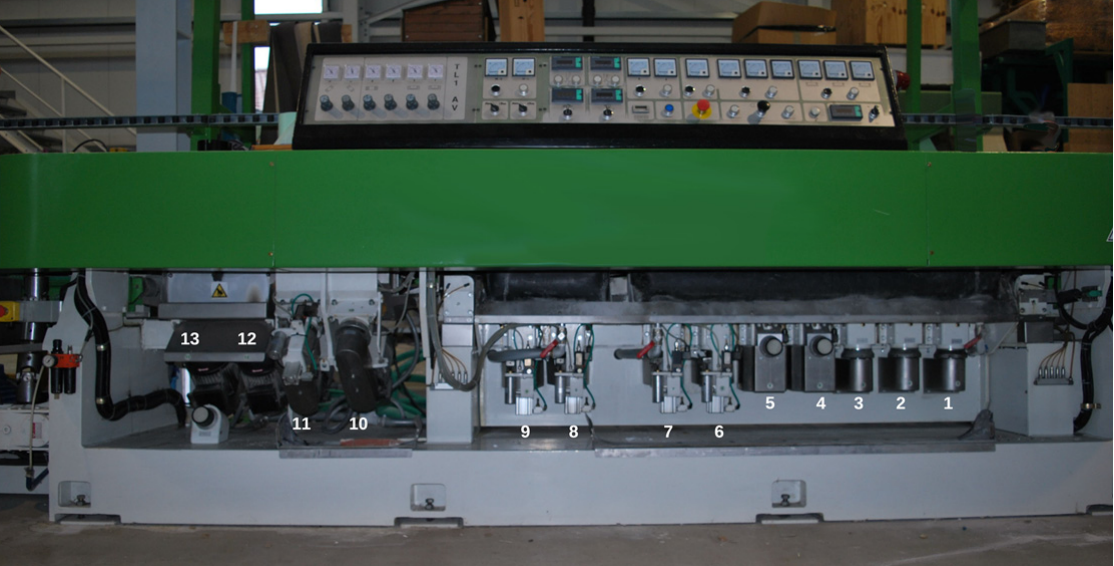
Fig. 6 Edger used for the edge processing of all specimens (manufacterer name